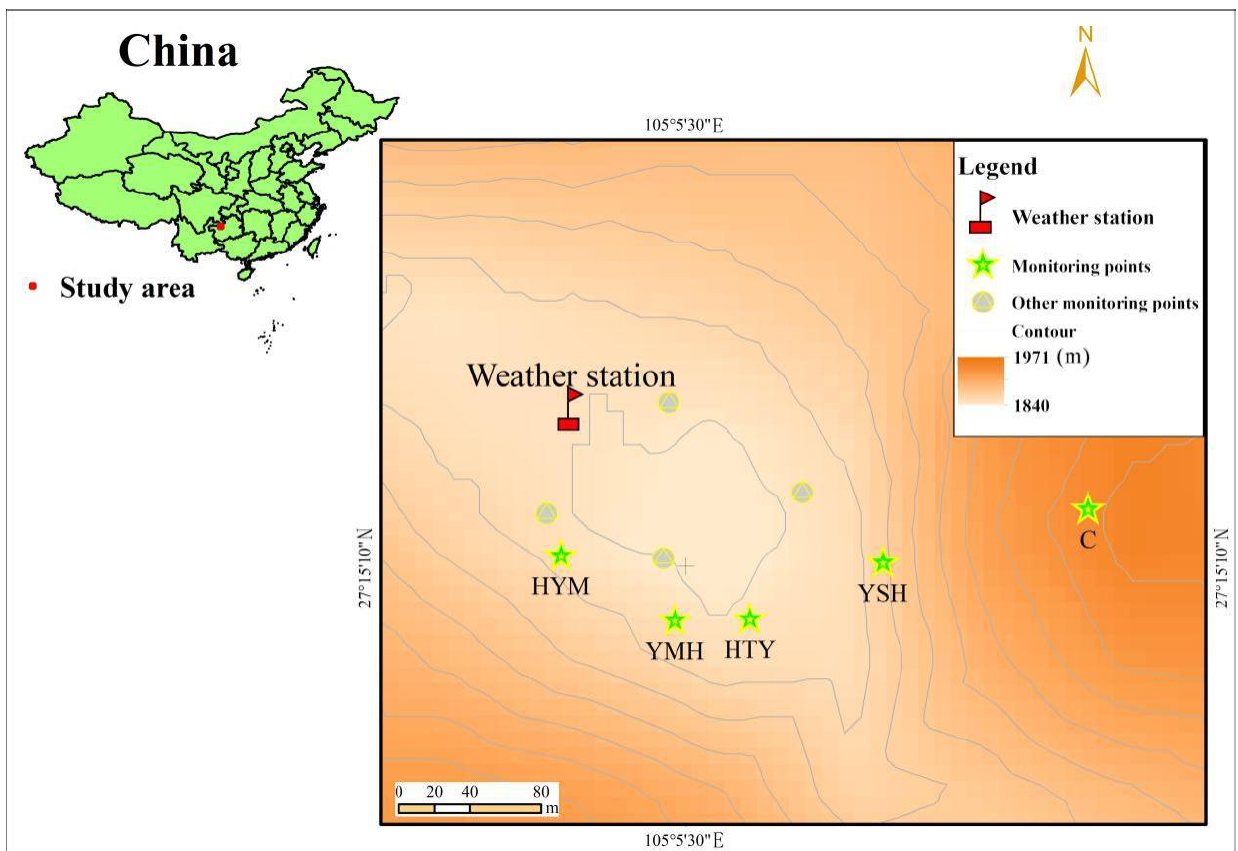
Figure 1. Location of the study area.